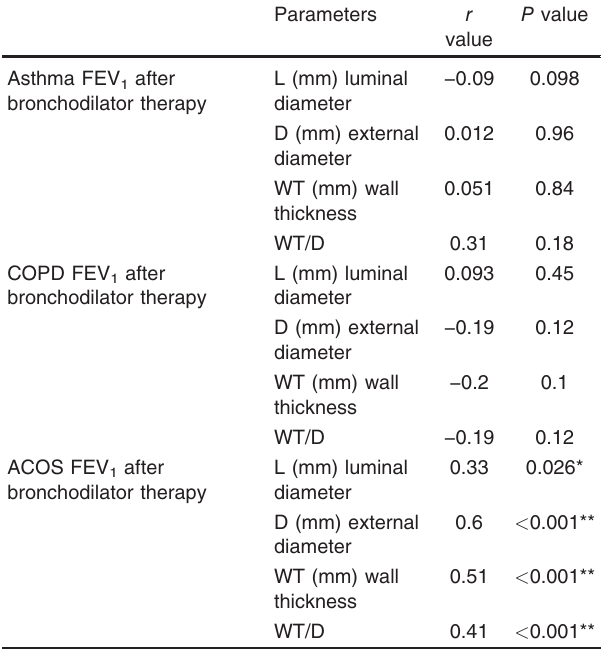
Table 5 Correlation of a forced expiratory volume in 1s after bronchodilator therapy with airway dimensions assessed in HRCT among asthma, chronic obstructive pulmonary disease and asthma – chronic obstructive pulmonary disease overlap